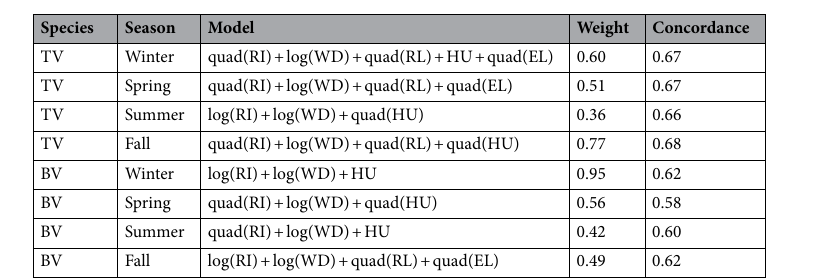
Table 1. Top-ranked models comparing used and available roost locations by vulture species and season, southern South Carolina, USA, 2006–2012. Species included were turkey vulture (TV) and black vulture (BV). Model covariates were collected in a 500 m buffer around points and included patch type richness (RI), high- density urban cover (HU), elevation (EL), total road length (RL), and distance to water (WD). Transformations applied to some covariates included quadratic (quad), and natural log